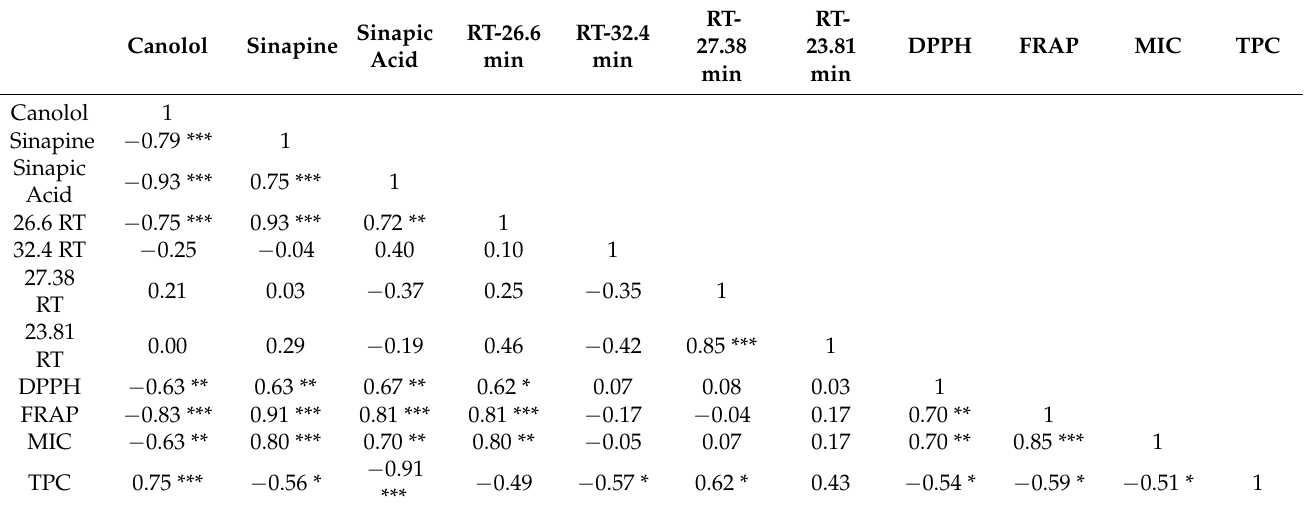
Table 2. Pearson correlation matrix between canola meal-derived sinapates, total phenolic content and antioxidant